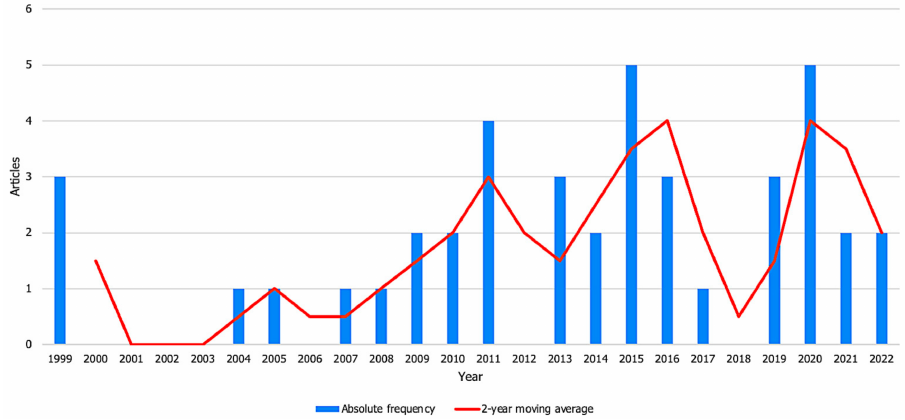
Figure 3. Number of papers published per